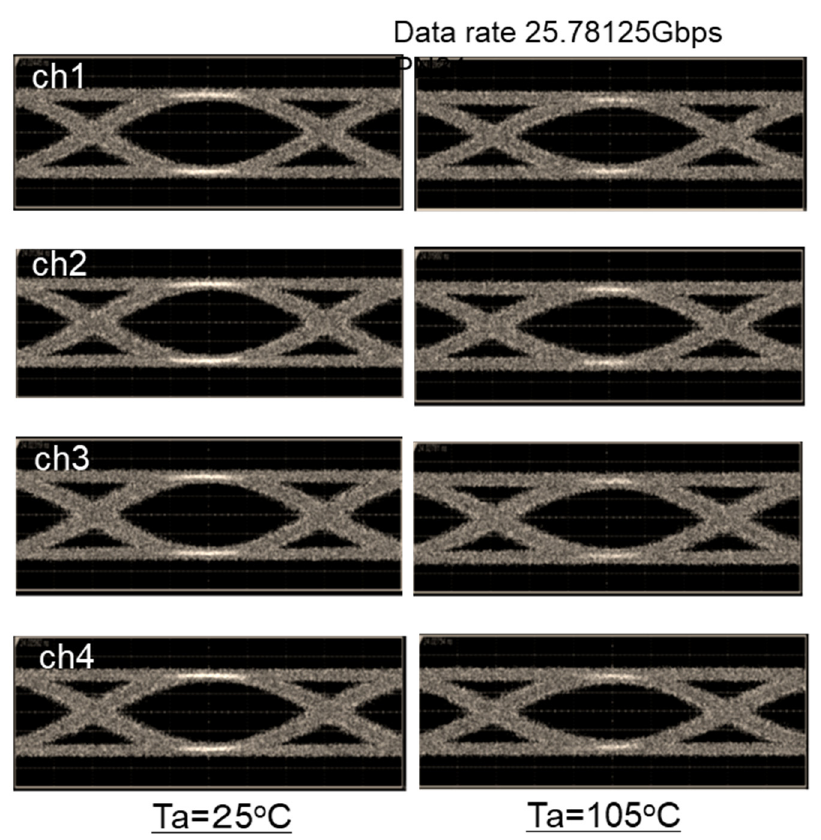
Figure 13. Optical eye diagrams on all four channels at 25 and 105 °C.